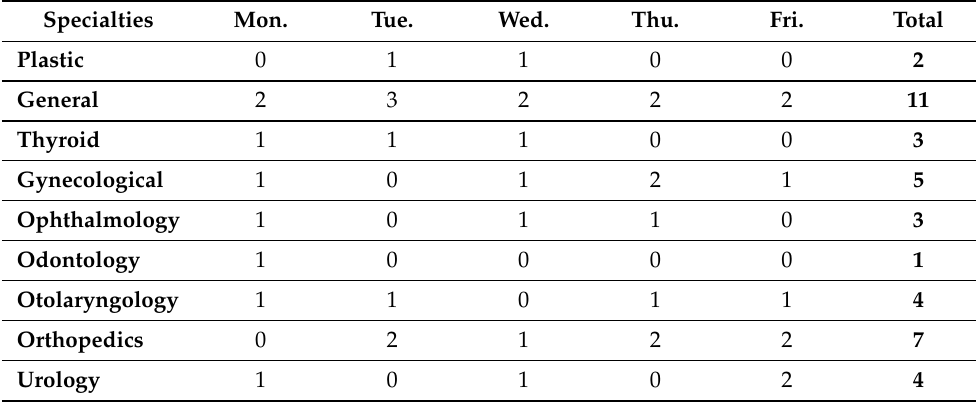
Table 4. New schedule with w 1 = w 2 = 0.5 and c s = 0. Specialties Mon. Tue. Wed. Thu.